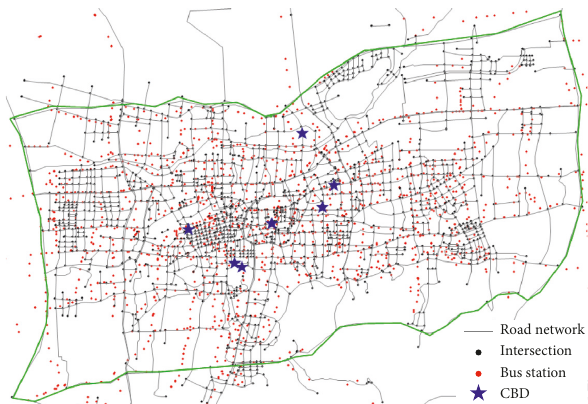
Figure 6: Intersection, bus station, and CBD of the study area.